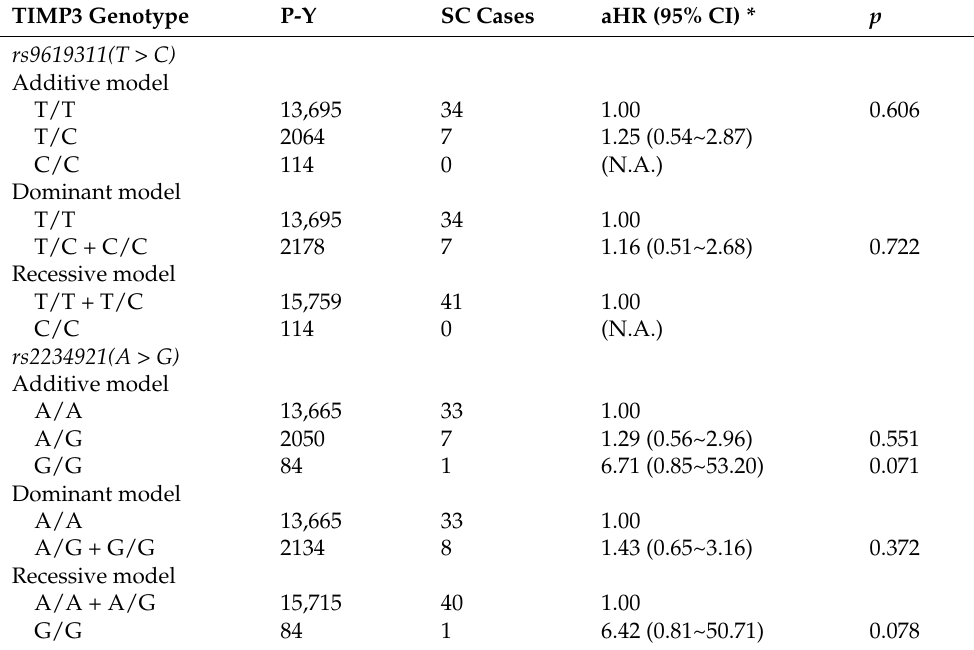
Table 3. Hazard ratios (HRs) of skin cancer in relation to the TIMP3 rs9619311 and rs2234921 genotypes. TIMP3 Genotype